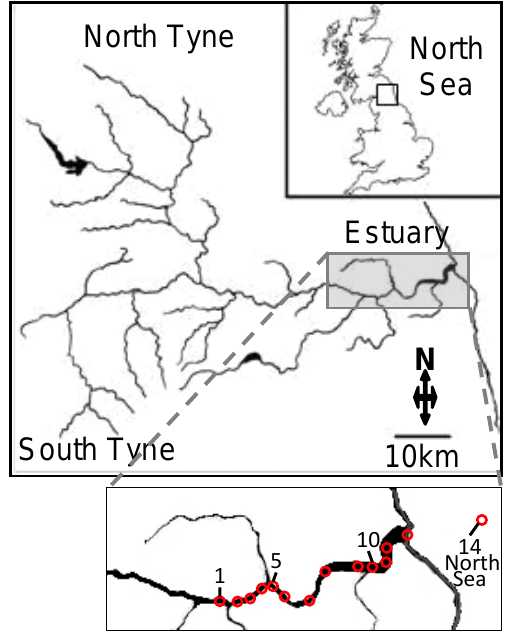
Fig. 1. Tyne catchment with North Tyne, South Tyne and Tyne estuary marked. Inset: map of UK showing location of the Tyne catchment. Red circles indicate the locations of stations described in Table